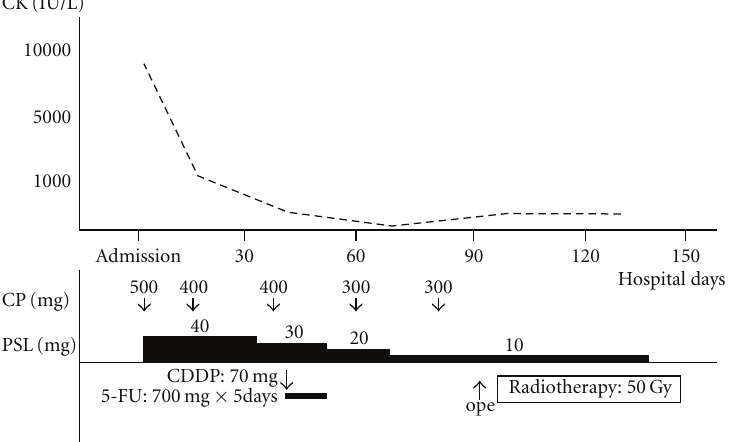
Figure 2: Case 1: Clinical Course. Treatment and serum CK levels are shown. CP: cyclophosphamide.